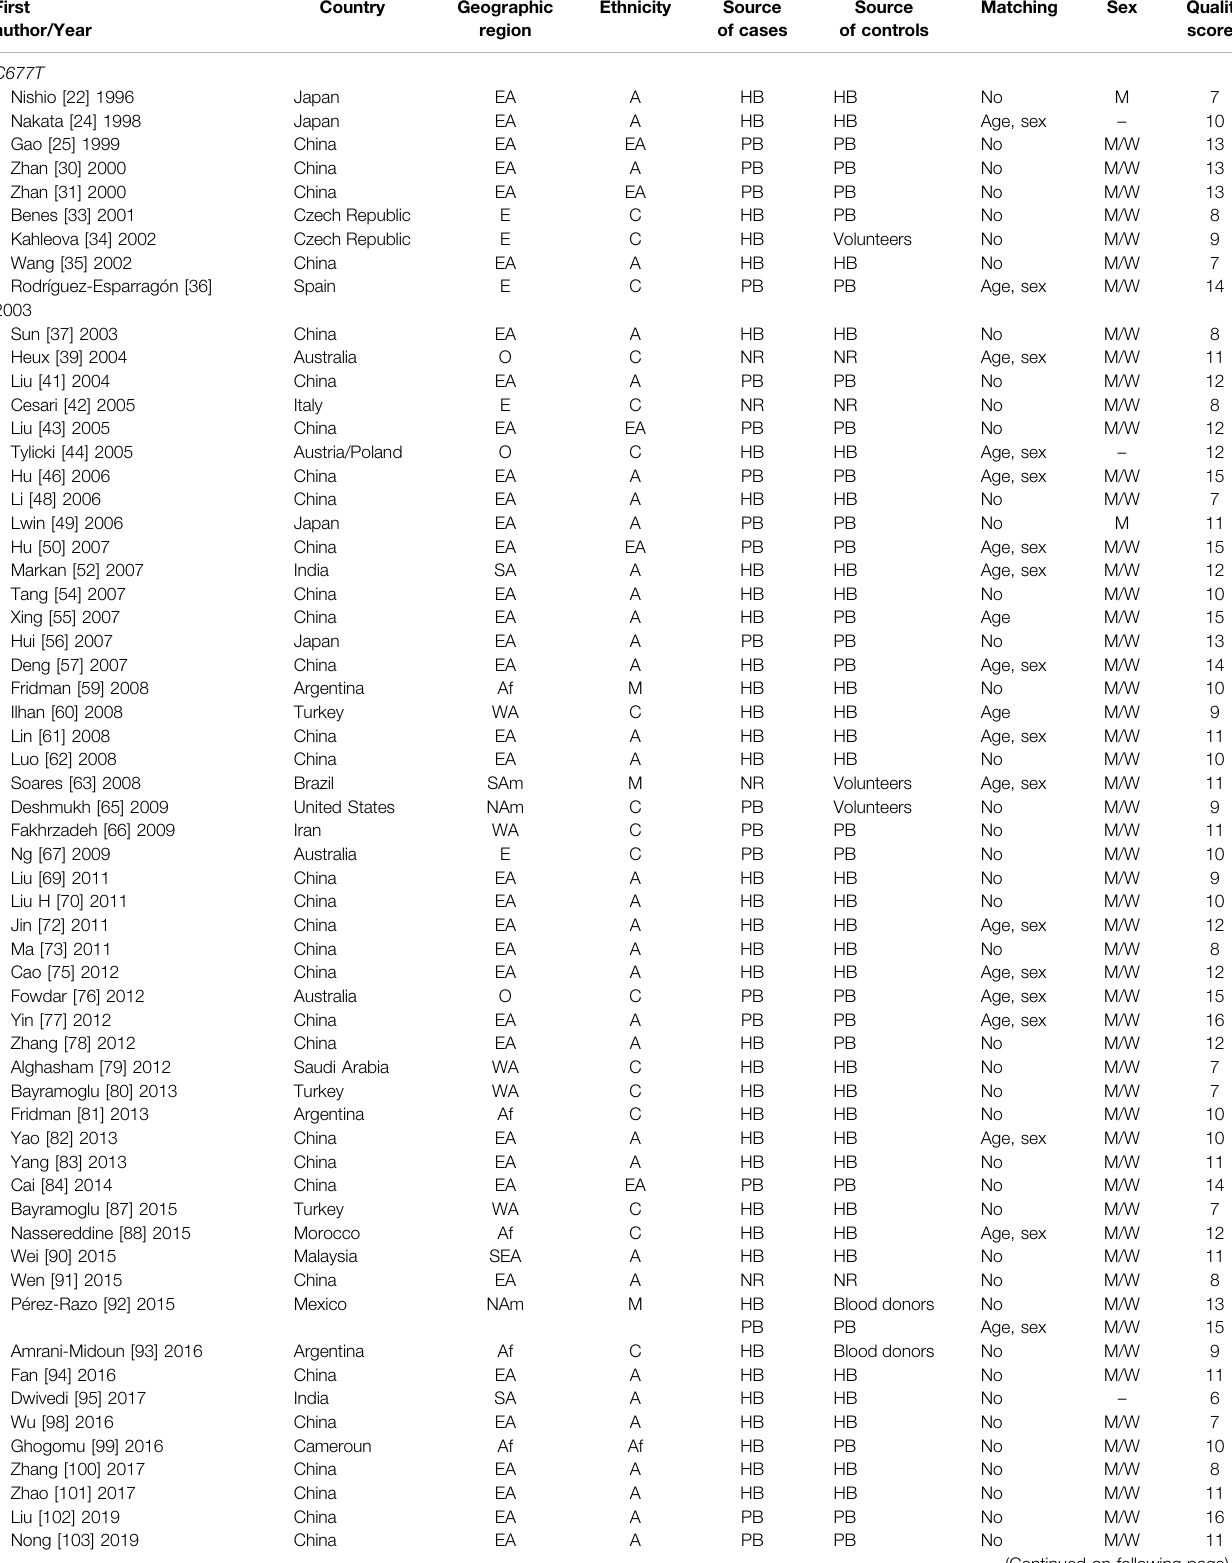
TABLE 2 | General characteristics of the included studies and literature quality